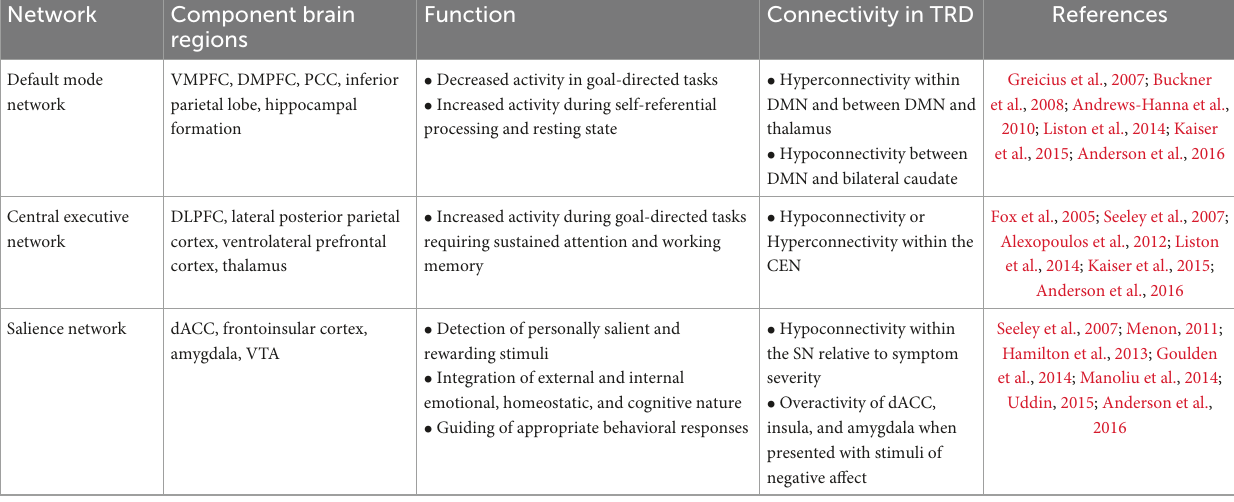
TABLE 1 Intrinsic connectivity networks in treatment-resistant depression (TRD).